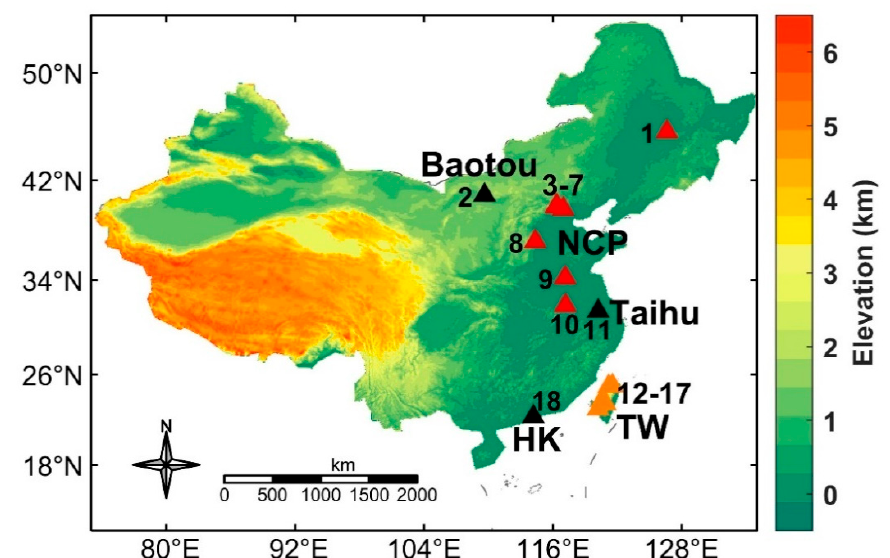
Figure 1. Distribution of the Aerosol Robotic NETwork (AERONET) sites in China. Red sites labeled with 1 and 3–10 are grouped into the North China Plain (NCP) region, orange sites of 12–17 into the Taiwan (TW) region. Three black sites (2, 11, 18) are named as Baotou, Taihu, and Hong Kong (HK), respectively. Color-bar represents the elevations from the digital elevation model provided by the Shuttle Radar Topographic Mission of National Aeronautics and Space Administration.